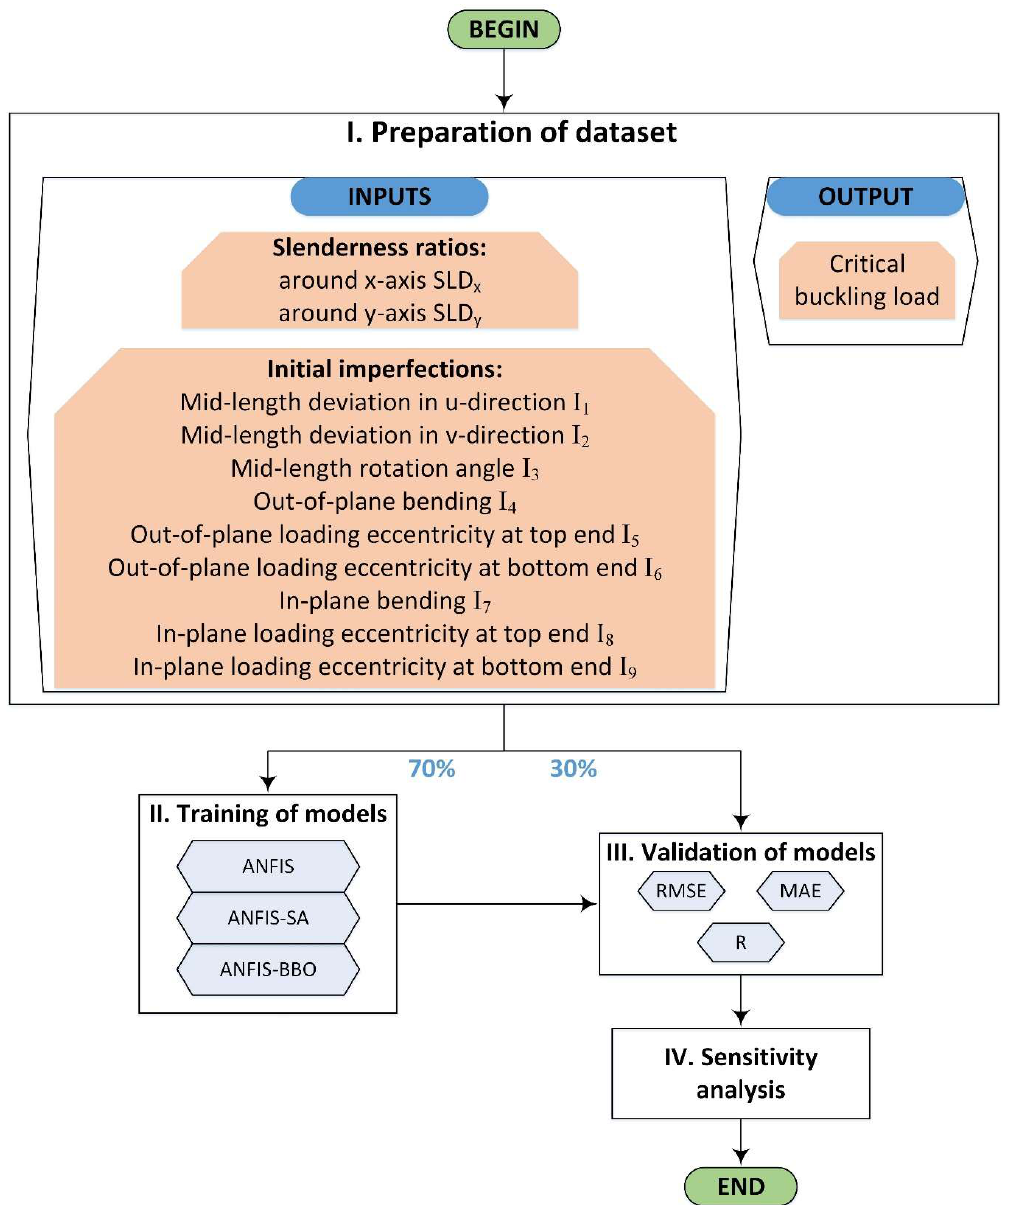
Figure 3. Methodology flow chart of this study.